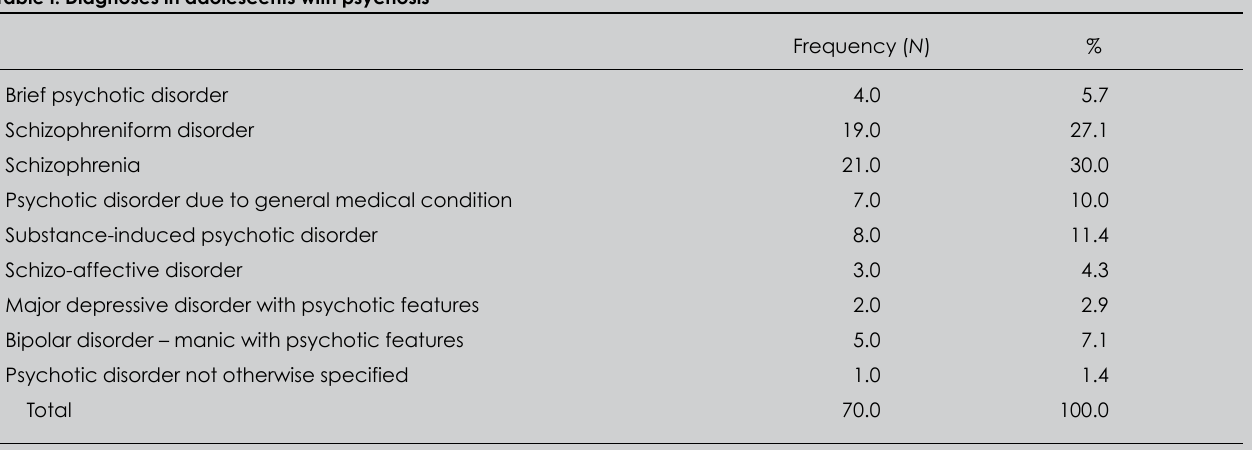
Table I. Diagnoses in adolescents with psychosis